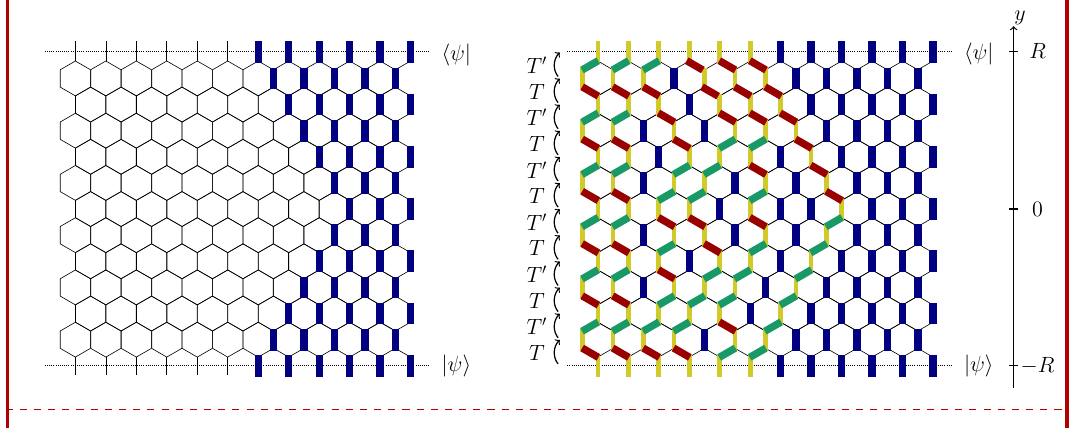
Domain wall geometry (left). Right: typical configuration with domain wall boundary conditions. The particles (fermions) are shown in